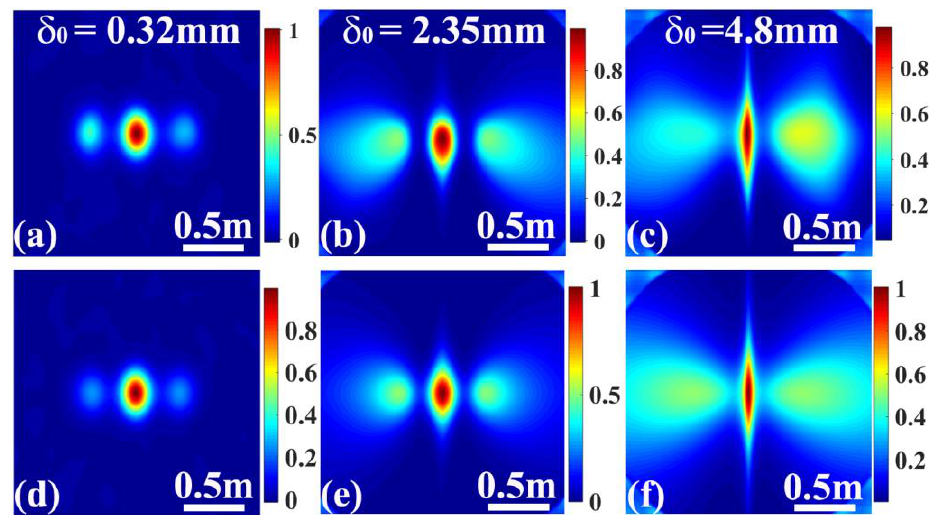
Figure 4. Density plots of the modulus of the square of the degree of coherence of a general partially coherent beam at a propagation distance z = 1000 m, with the initial coherence width δ 0 = 0.32 mm in ( a , d ), δ 0 = 2.35 mm in ( b , e ), and δ 0 = 4.8 mm in ( c , f ). The p function used in ( a – c ) is the soccer patter